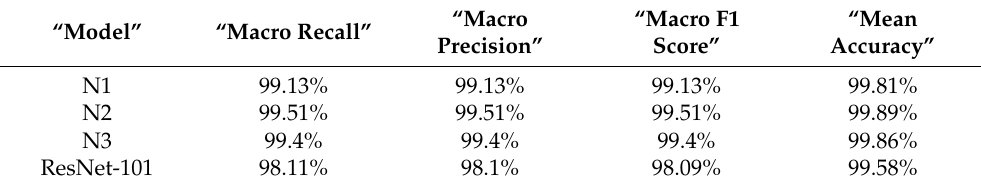
Table 6. Performance parameters for the classification of nine classes of Tomato plant.